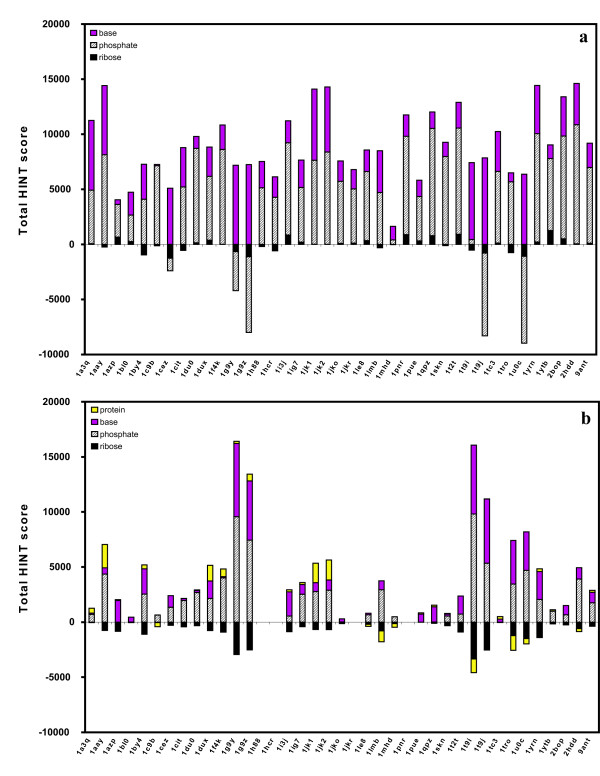
a) Contributions of various structural components of the protein-DNA association. Shown are protein-DNAphosphate, protein-DNAribose and protein-DNAbase-edge contributions, colored as indicated in the legend. b) HINT score contributions calculated for the interaction between water molecules (having total Rank ≥ 4 and non-zero Rank with both macromolecules) and the protein-DNA interface. Shown are the water-DNAphosphate, water-DNAribose, water-DNAbase and water-protein contributions, colored as indicated in the legend. Bars corresponding to 1h88, 1hcr, 1jkr and 1pnr complexes are missing because no significant crystallographic water molecules were found in the crystal structures.